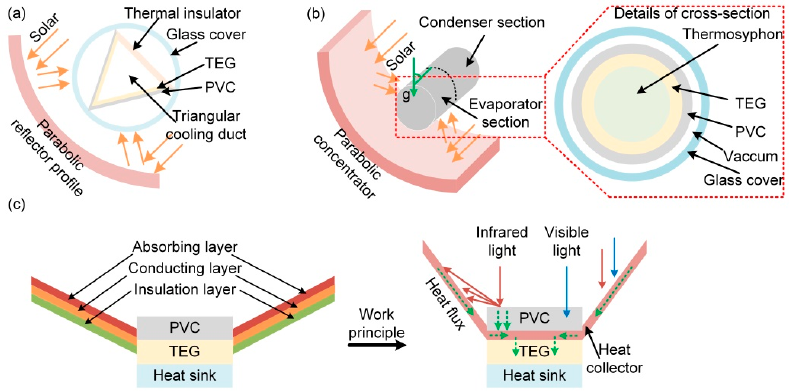
Figure 5. Schematic illustration of ( a ) triangular, ( b ) thermosyphon-technology-based, and ( c ) ab- sorption–conduction–insulation hybrid